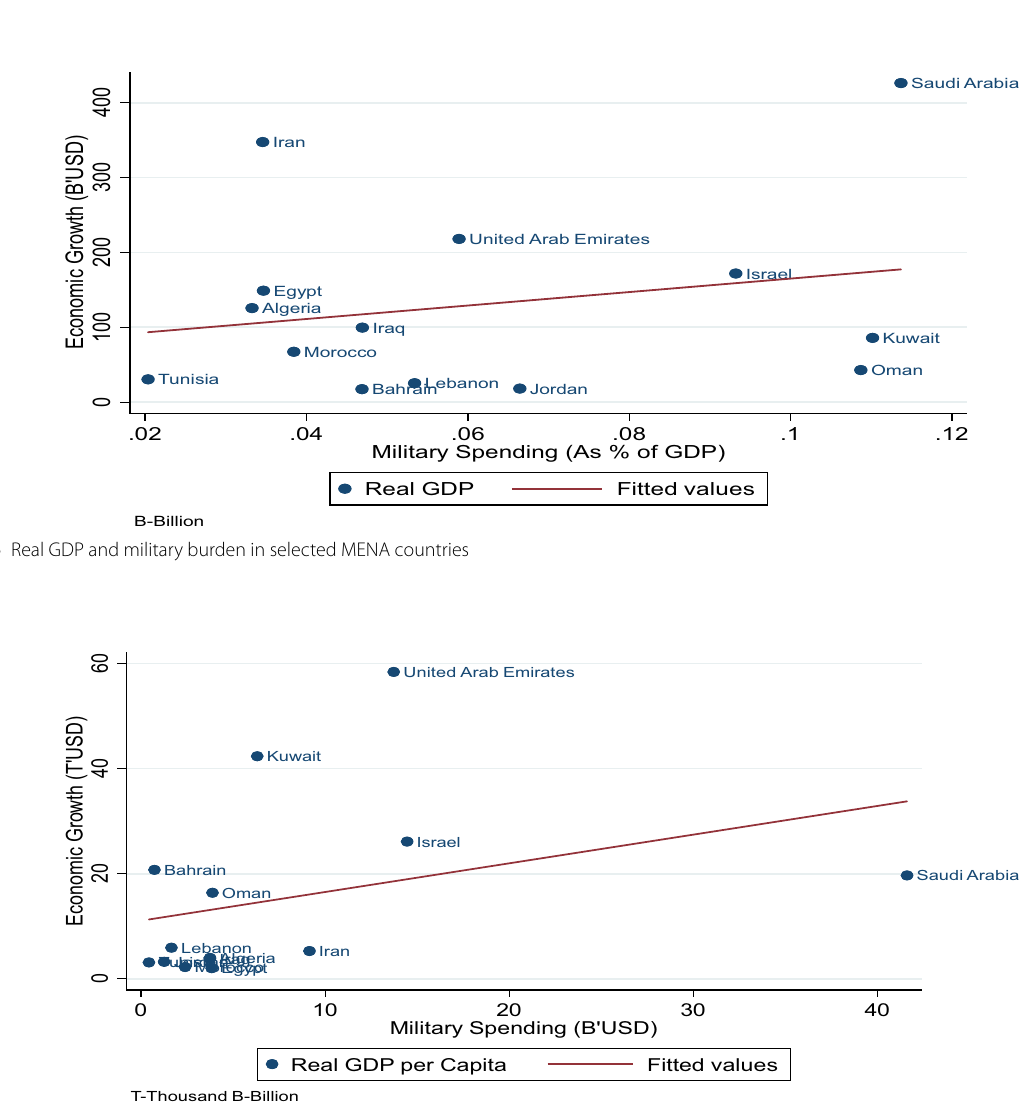
Fig. 7 Real GDP per capita and military spending in selected MENA